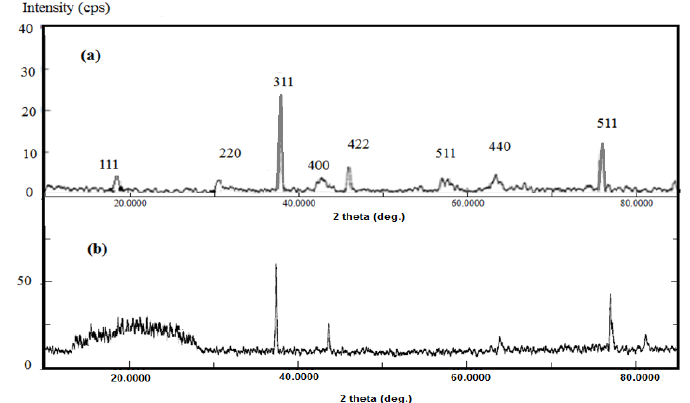
Figure 3. X-ray diffraction (XRD) difffractograms of ( a ) Fe 3 O 4 ·VS/AMPS and ( b ) VS/AMPS·Fe 3 O 4 .